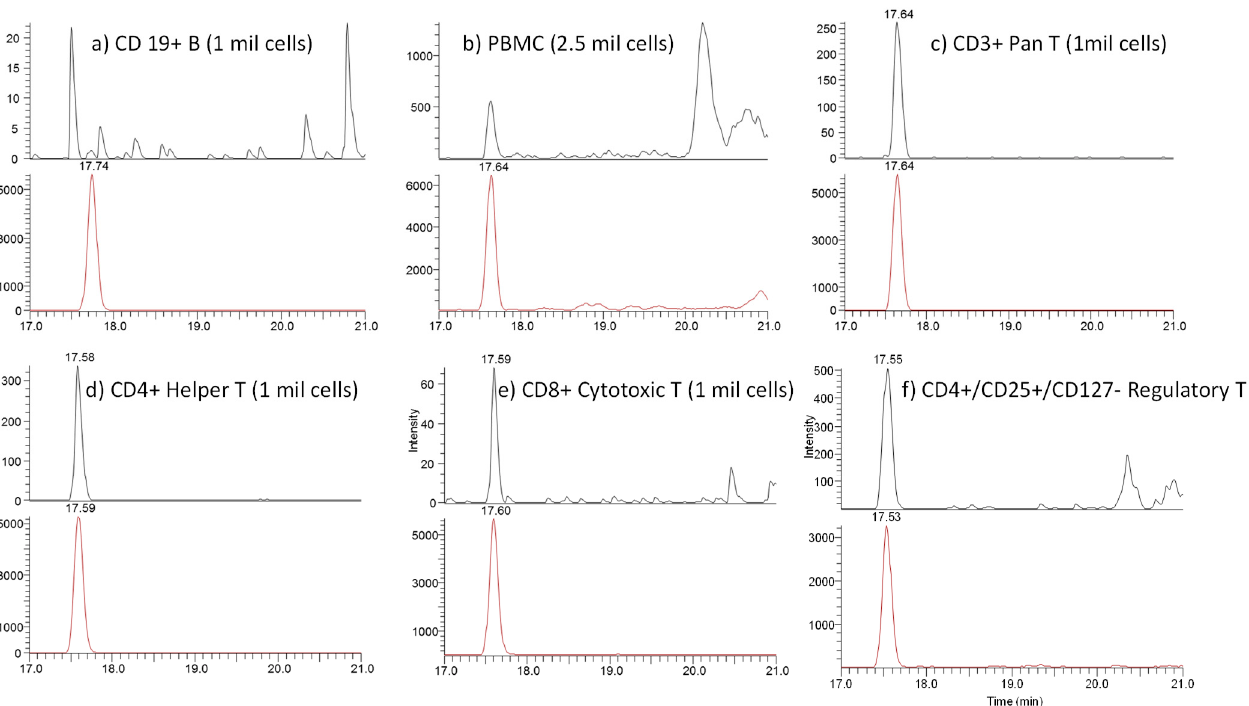
Figure 3. The representative LC-MRM MS Chromatograms for cell samples with analyte ( top ) and IS ( bottom ).